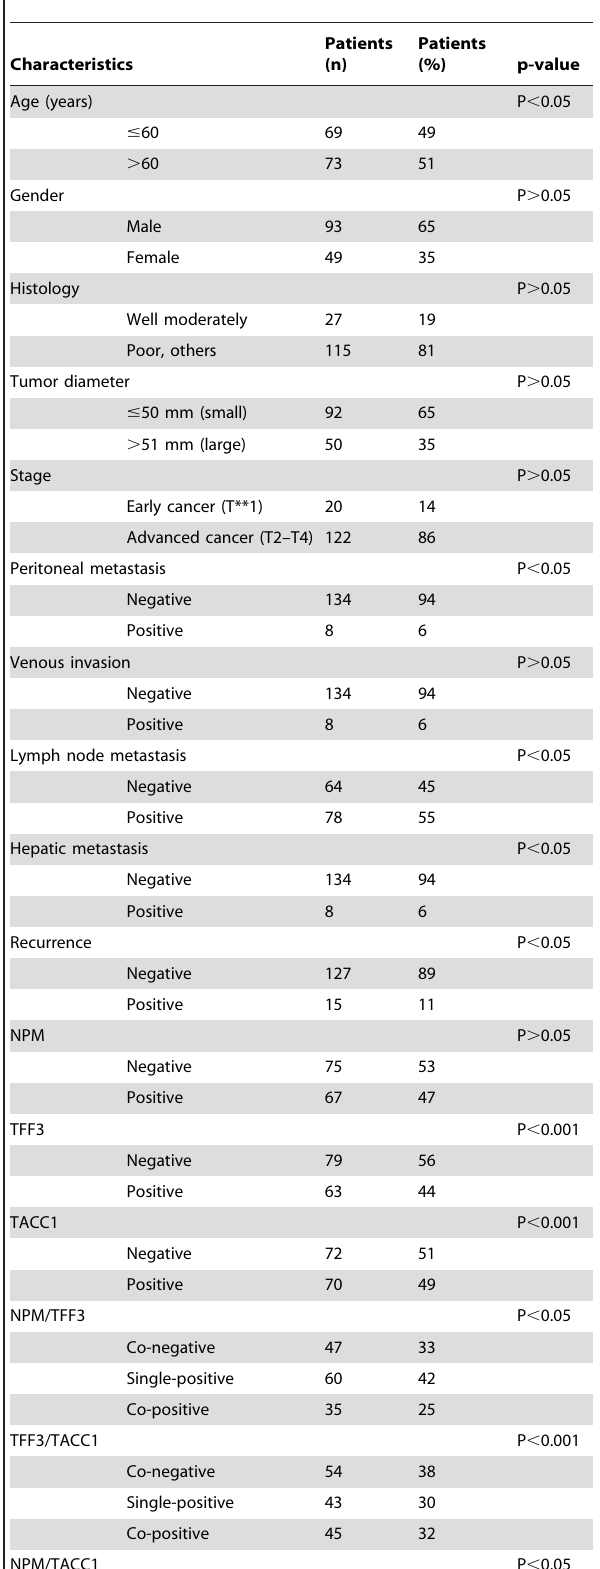
Table 3. Univariate analysis with respect to overall survival in 142 GC patients (univariate analysis; log-rank test).